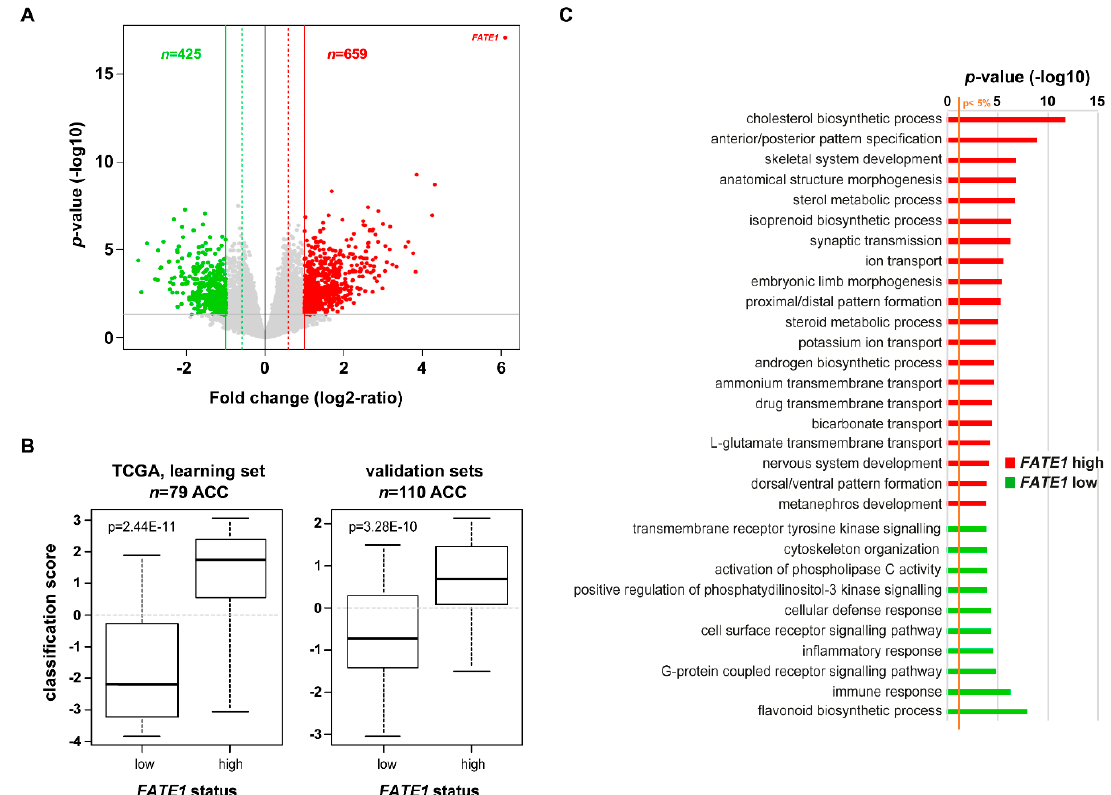
Figure 4. FATE1 -coregulated genes in ACC. ( A ) Volcano plot of transcripts were significantly associated with FATE1 high- ( n = 44) and low-expressing ( n = 35) ACC within the TCGA cohort. ( B ) Validation of the 1084-gene signature: box-plot of the metagene-based prediction score in the “ FATE1 -high” samples compared to the “ FATE1 -low” samples. The p -value is for the Student’s t-test assessing the difference of the prediction score between the observed FATE1 classes, which is, as expected, very significant not only in the learning set (left), but also in the validation set (right), showing the robustness of the signature ( C ) Biological Processes (GO) differentially coregulated in association with FATE1 high vs . low expression levels.